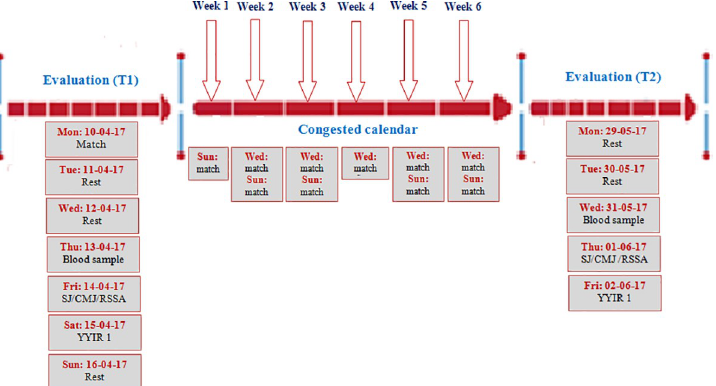
Fig 1. Experimental design. Evaluation T1: Before the period of match congestion Evaluation T2: After the period of match congestion Congested calendar: A six-week period of congested match play Mon: Monday, Tue: Tuesday,